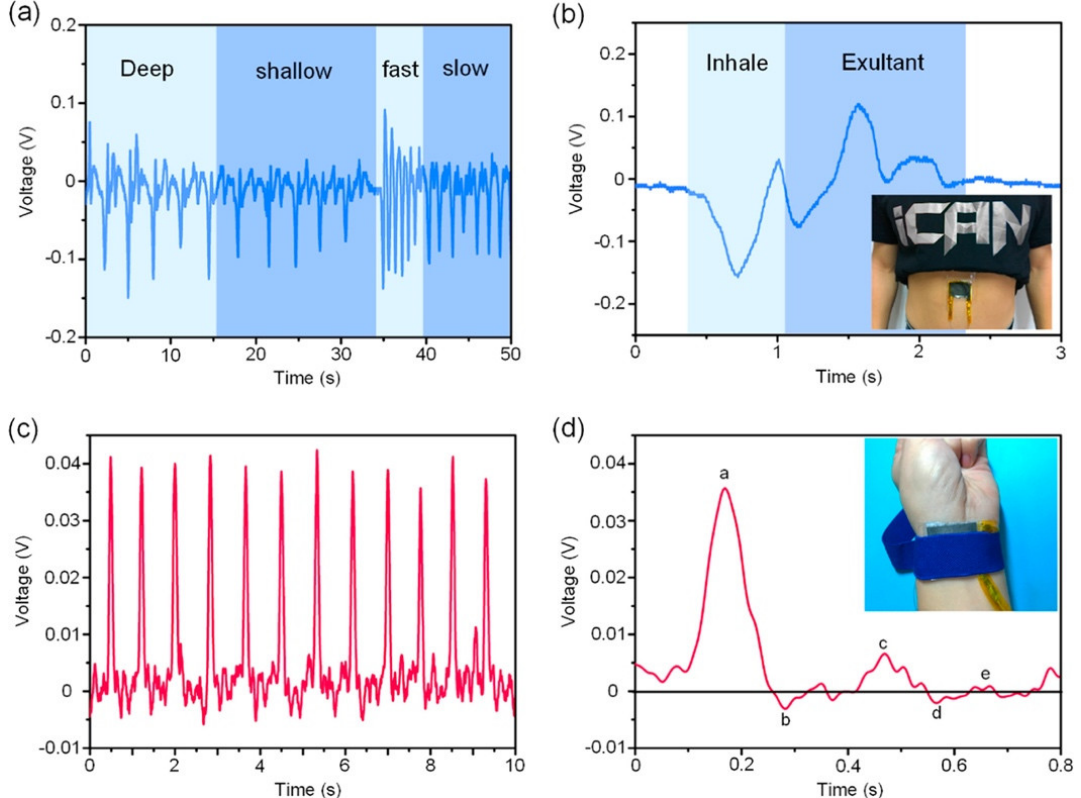
Figure 4. Results of real-time physiological monitoring using the flexible hybrid nanogenerator de- veloped by Chen et al. [103]. ( a ) Respiration signal during 50 s with four different breathing modes such as deep, shallow, fast, and slow. ( b ) The enlarged signal in one breath cycle of a patient, which was measured using the hybrid nanogenerator attached to the belly. ( c ) The real-time artery pulse signal and ( d ) its enlarged signal of output voltage in one cycle that was measured with the hybrid nanogenerator. Reprinted with permission from [103]. Copyright 2017, Elsevier Ltd.